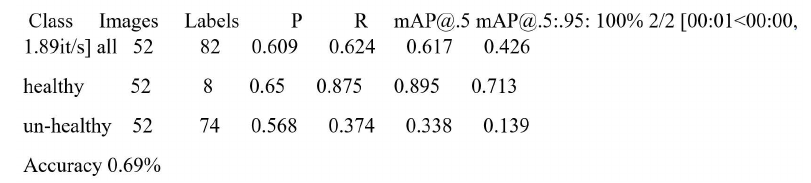
Figure 18. YOLOv5